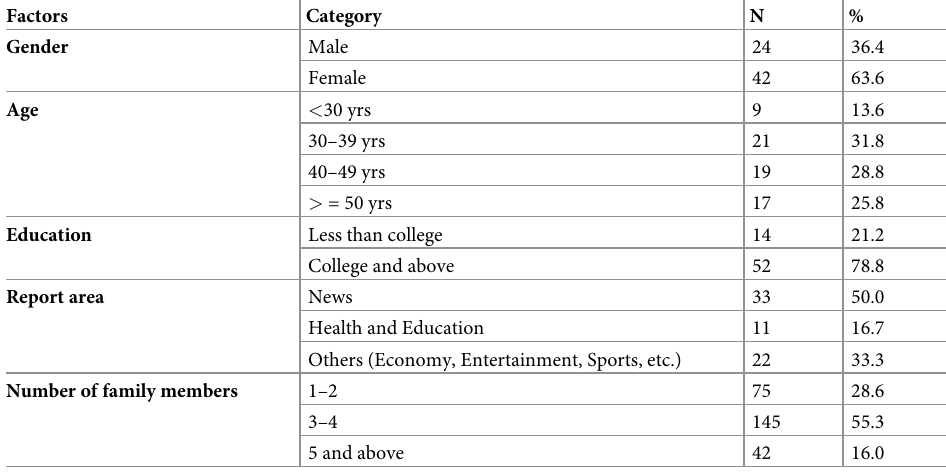
Table 1. Demographic characteristics of reporters (n = 66) participating in the study.